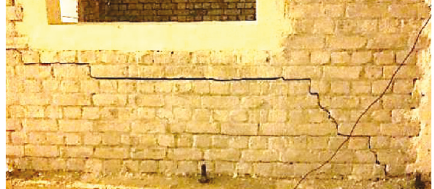
Figure 11: Combination of flexure and shear cracks in the out-of- plan wall corresponding to story drift of 0.65%.